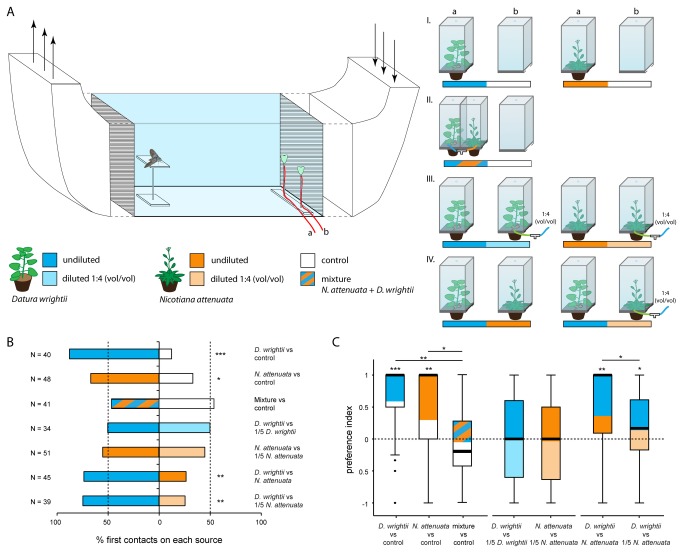
Effects of host blend composition and intensity on host choice in M. sexta.(A) Choice experiments with gravid M. sexta females were performed in a wind tunnel. Plants were placed in glass boxes outside the wind tunnel where they could not be seen by the moths. Pumps delivered plant headspace to two surrogate leaves serving as visual stimuli inside the wind tunnel. Two host plants, D. wrightii and N. attenuata, were tested (I) against a clean air control, (II) with their plant headspaces mixed together 1:1 against a clean air control, (III) against a conspecific plant whose headspace was diluted with clean air, and (IV) against each other, with N. attenuata headspace either not manipulated or diluted with clean air. Plant headspace and clean air were mixed in a 1:4 (vol/vol) ratio resulting in a 5-fold dilution. (B) The percentage of first choices made in the corresponding experiments. Sample size is given next to each experiment. Asterisks denote significant differences between sources (Binomial Test, *** p<0.001; ** p<0.01; *p<0.05). (C) Boxplots depict preference indices calculated from the number of contacts to each source. Values close to 1/-1 represent a high preference for one source; 0 means no preference. The black line delineates the median; color distribution within the box represents the percentage of contacts to each source. Asterisks above the boxes denote indices significantly different from 0 (Wilcoxon Signed Ranks Test, *** p<0.001; ** p<0.01; * p<0.05). Preference indices resulting from experiments in which the plant headspace of both species is offered superimposed or separately against clean air differed significantly (Kruskal-Wallis Test, p<0.0001, and Dunn’s post hoc test, ** p<0.01, * p<0.05). Furthermore, preference indices derived from interspecific choice experiments were significantly different from each other (Mann-Whitney U Test, p<0.05).